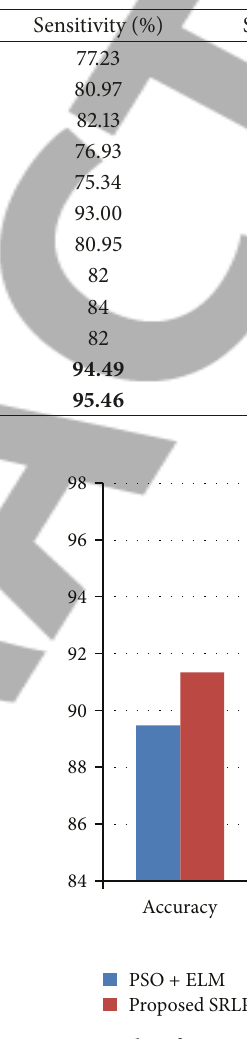
Figure 8: Classification rate for Cleveland Heart Disease